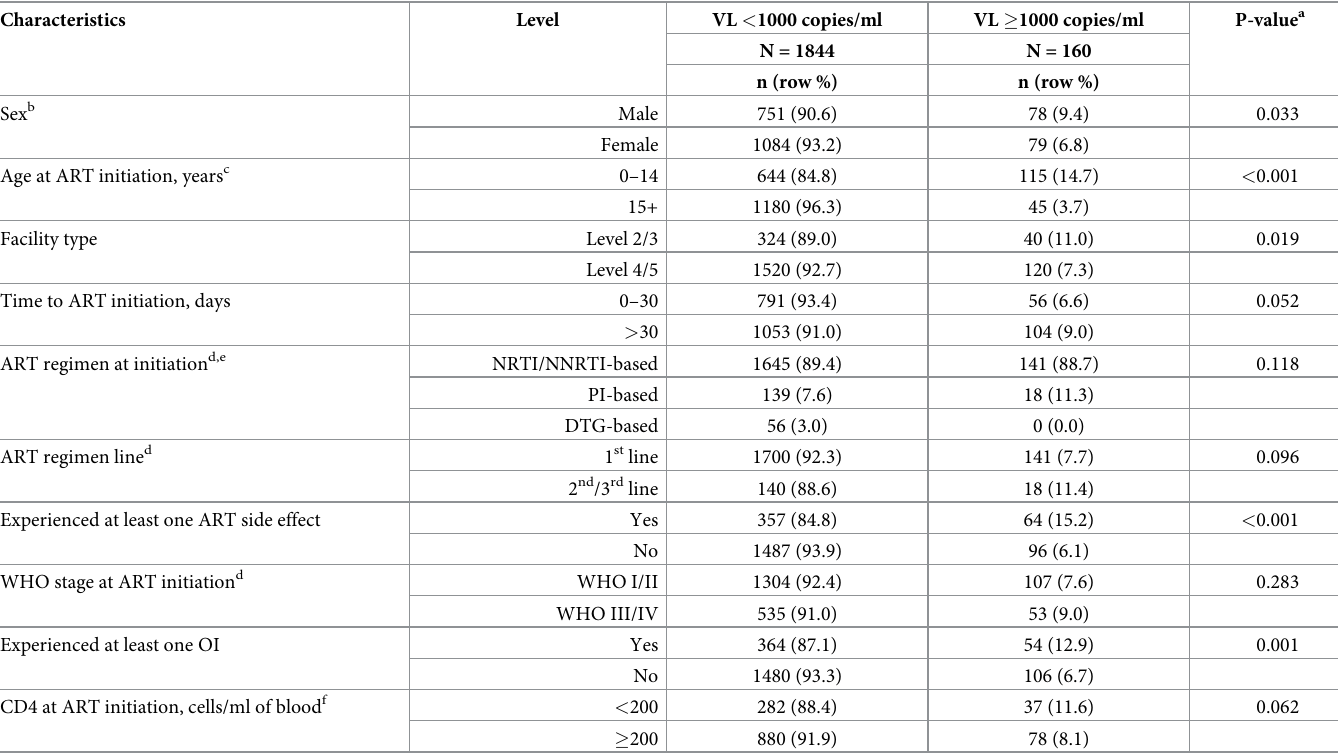
Table 2. Characteristics of study participants by viral load; VL < 1000 copies vs confirmed VL � 1,000